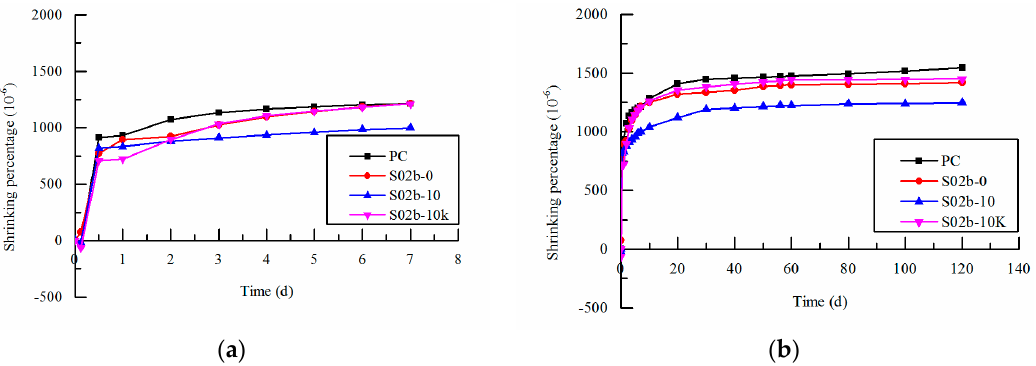
Figure 6. Effects of SAP on total shrinkage of concrete: ( a ) the early age; ( b ) the later age, S02b-10 and S02b-10K are pre-absorbed, and S02b-0 is non-absorbed.